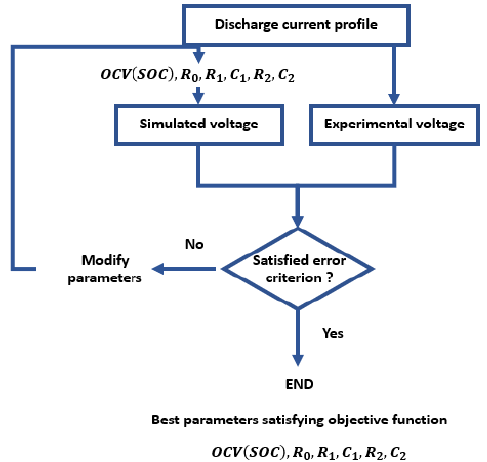
Figure 7. Flow diagram of the estimation procedure [30].